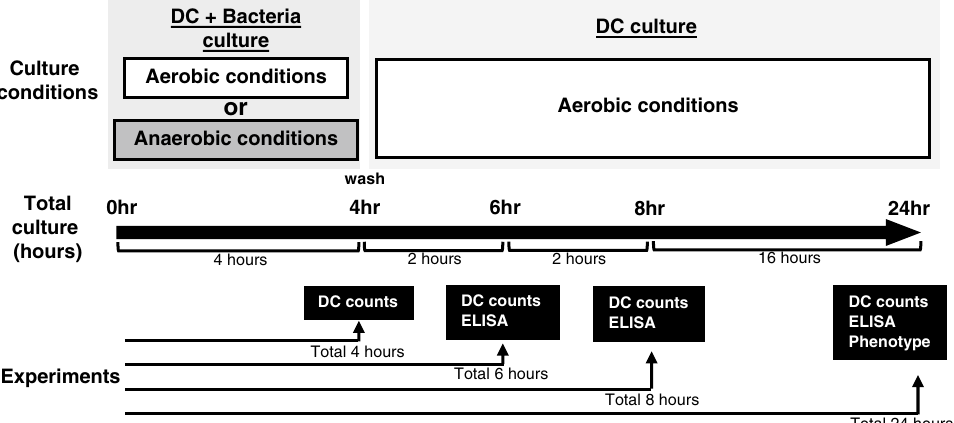
Figure 1. Stimulation of the DC line with live commensal bacteria. The human DC line was cocultured with each live commensal bacteria for 4 h under aerobic (white square) or anaerobic (black square) conditions. After coincubation, the DC line was washed to remove commensal bacteria and further incubated for 2, 4, or 20 h under aerobic (white square ) conditions (total of 6, 8, or 24 h).